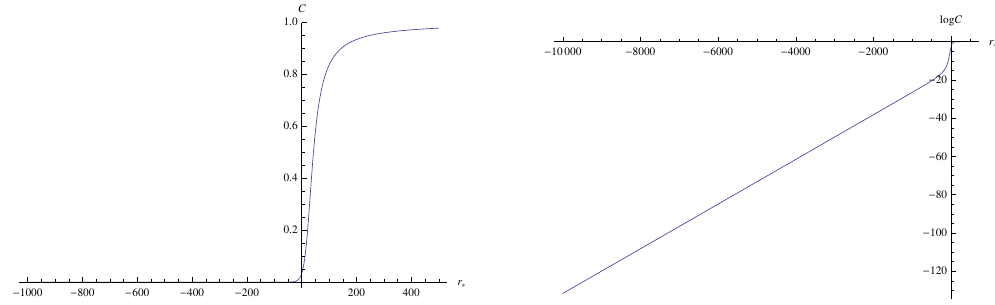
Figure 3 . The factor C for (cid:20)m 0 = 25, r (cid:3) s = (cid:0) 60 < a (cid:3) , a 0 = 10 and (cid:11) = 0 : 05. The plot on the left shows that C becomes very small around and inside the neck. The plot on the right shows that the behavior of C at large negative r (cid:3) resembles that of the vacuum solution described in section 3.2, with log C = 2 (cid:26) proportional to r (cid:3) ( / r 2